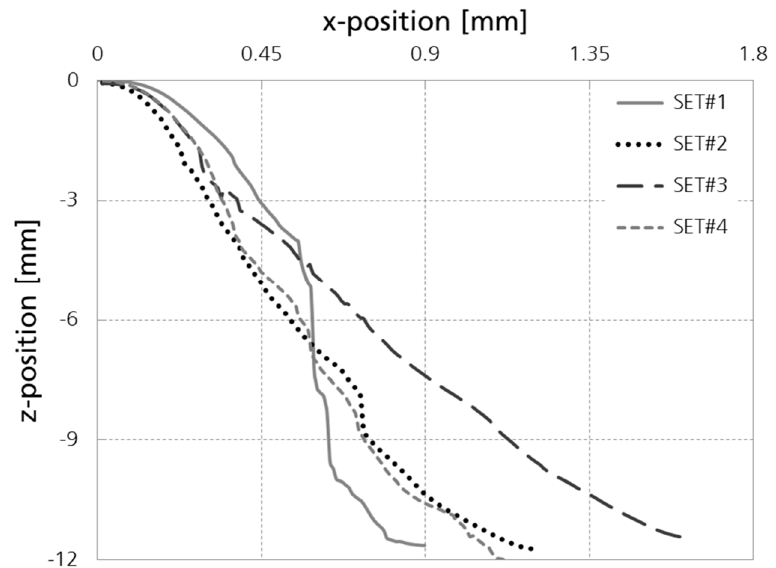
Figure 11. Topography of the cut front of 12 mm stainless steel cut with the following parameters: Set #1: Static beam shaping; and different values of the longitudinal, linear beam oscillation parameters; Set #2: 300 µm amplitude and 500 Hz frequency; Set #3: 550 µm amplitude and 500 Hz frequency; Set #4: 300 µm amplitude and 2000 Hz frequency.